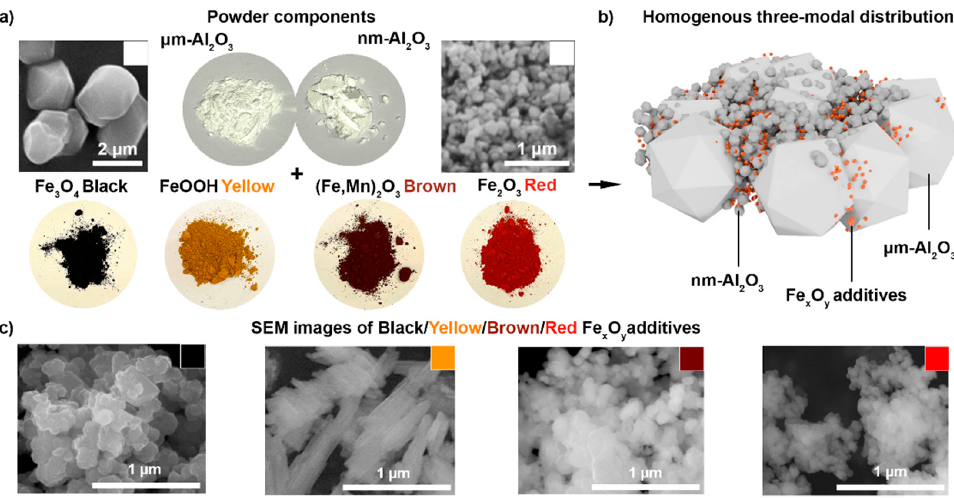
methods” section. The powdered additives (Figure 1a) have intense colors, which are aimed to increase the overall absorption of the white-colored alumina precursor powder at the applied wavelength range (400–800 nm). A homogenous three-modal distribution (400–800 nm). A homogenous three-modal distribution was obtained with the nanometer was obtained with the nanometer Al 2 O 3 and Fe x O y additives that filled the gaps between Al 2 O 3 and Fe x O y additives that filled the gaps between the micrometer Al 2 O 3 particles the micrometer Al 2 O 3 particles (Figure 1b). SEM images of the black/yellow/brown and (Figure 1b). SEM images of the black/yellow/brown and red Fe x O y pigments (Figure 1c) red Fe x O y pigments (Figure 1c) demonstrate that red α -Fe 2 O 3 , black Fe 3 O 4 , and brown (Fe, demonstrate that red α -Fe 2 O 3 , black Fe 3 O 4 , and brown (Fe, Mn) 2 O 3 nanoparticles have Mn) 2 O 3 nanoparticles have a spherical shape, with average sizes of 90, 150, and 300 nm, a spherical shape, with average sizes of 90, 150, and 300 nm, respectively (material data respectively (material data specification), while yellow α -FeOOH particles, with a 200 nm specification), while yellow α -FeOOH particles, with a 200 nm × 300 nm size, have a × 300 nm size, have a prismatic elongated shape. Among the transition metals (Cr, Fe, Eu, prismatic elongated shape. Among the transition metals (Cr, Fe, Eu, Yb, Dy, Tb), the Yb, Dy, Tb), the Fe dopant not only enhances sintering, but also improves the catalytic, Fe dopant not only enhances sintering, but also improves the catalytic, magnetic, and magnetic, and optical properties of alumina due to the high surface density and the ion optical properties of alumina due to the high surface density and the ion radius close to the radius close to the Al [24,25]. By adding impurities, Fe 3+ ions enter the structure of alumina Al [24,25]. By adding impurities, Fe 3+ ions enter the structure of alumina and significantly and significantly reduce the bandgap of the material. reduce the bandgap of the material.